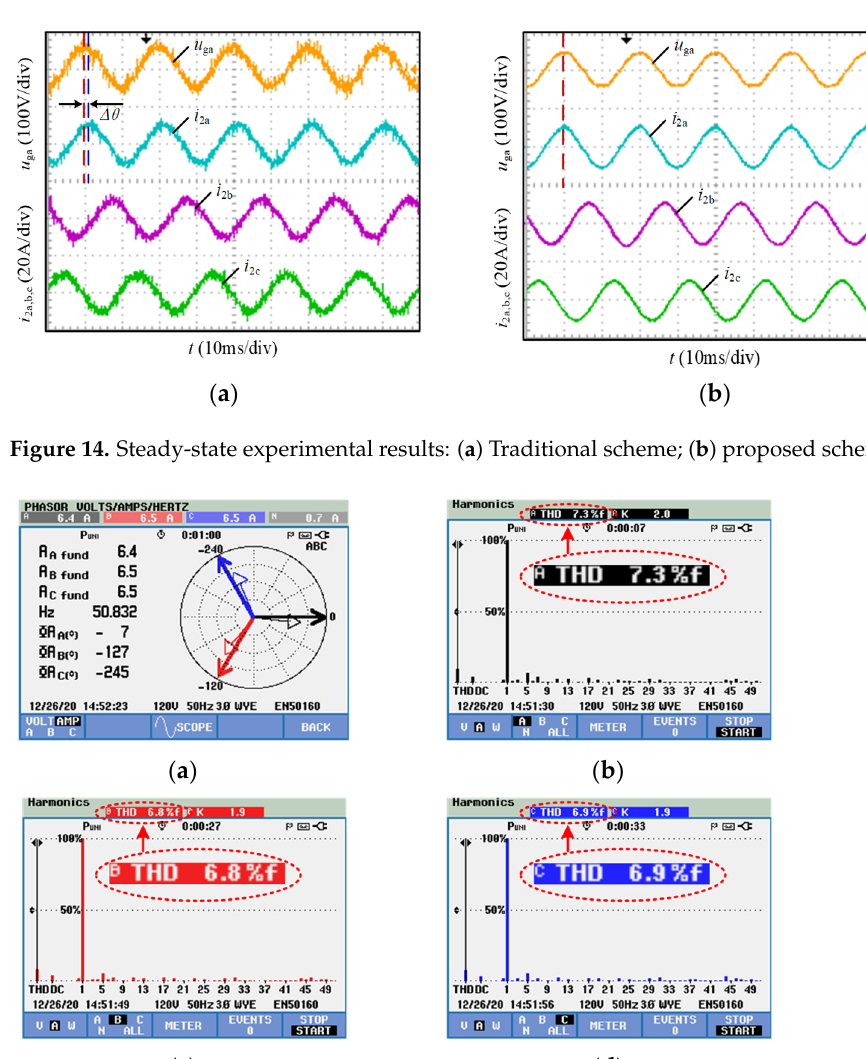
( d ) Figure 16. Power quality analysis results of the proposed methods. ( a ) The measurement results with; ( b ) THD of phase A grid-connected current; ( c ) THD of phase B grid-connected current; ( d ) THD of phase C grid-connected current.